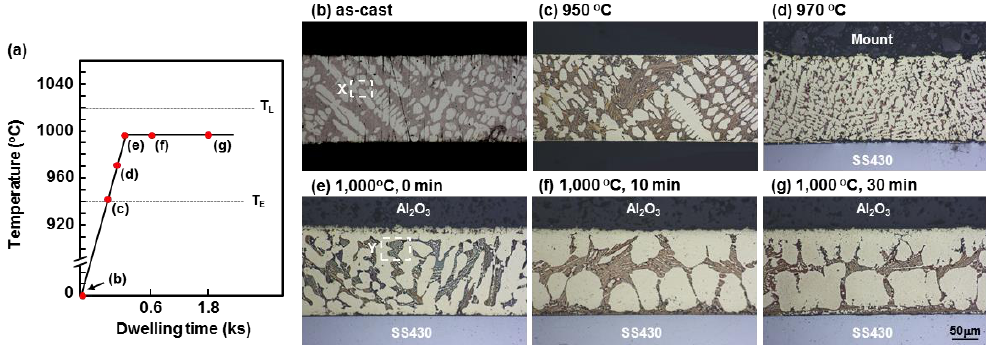
Figure 2. ( a ) Brazing heating cycle and the corresponding optical micrograph (OM) of a α-Al 2 O 3 /Cu- 7Al-3.5Zr/SS 430 joint brazed under ( b ) as-cast conditions and at ( c ) 950 °C for 0 min, ( d ) 970 °C for 0 min, and ( e – g ) 1000 °C for 0, 10, and 30 min, respectively.